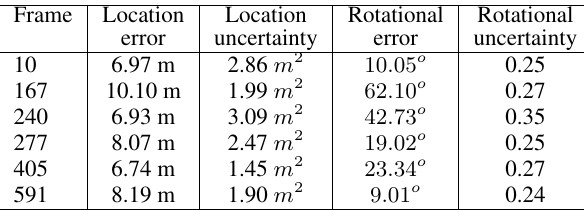
Figure 10. (a) shows the average normalised errors of the trajectory (b) shows the average normalised uncertainties of the trajectory and (c) shows corresponding points on the trajectory with high errors.